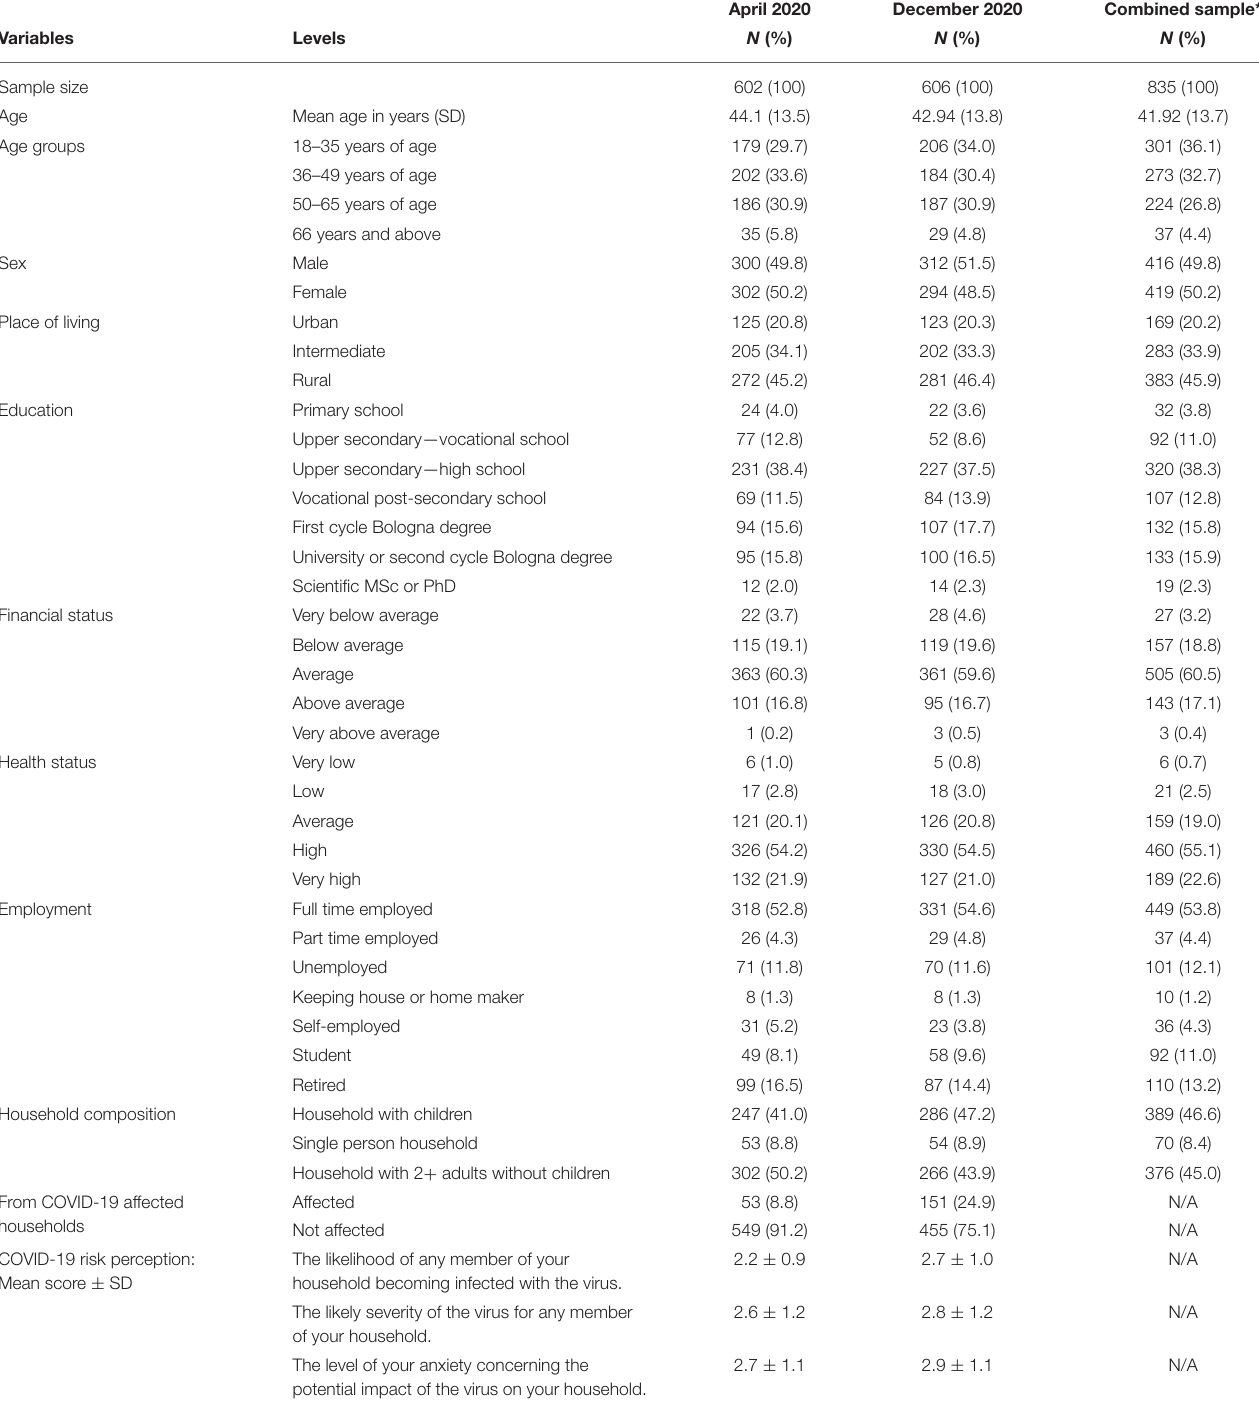
TABLE 1 | Socio-demographic and other characteristics of study participants (Slovenia,